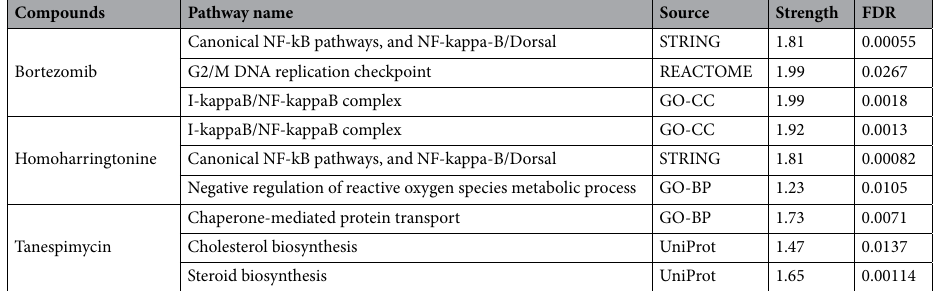
Table 4. Selective pathways identified using top genes predicted by Auransa engine to be reversed by anti- viral compounds based on STRING DB analysis. A clear NF k B signature was likely the driver for